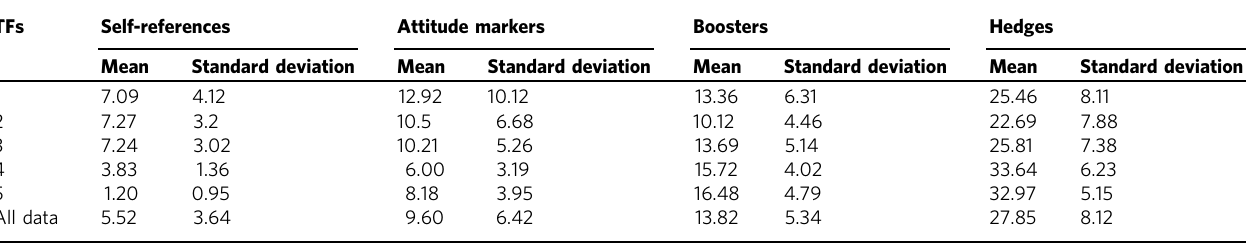
Table 3 Frequencies of self-references, attitude markers, boosters, and hedges per 1000 words over the study period.